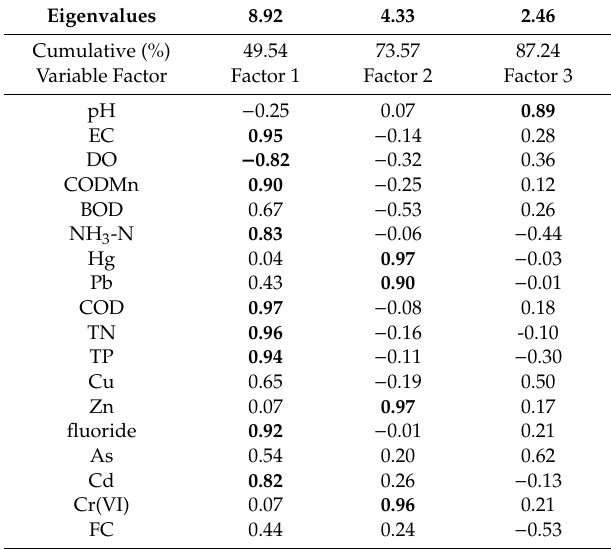
Table 2. Loads of 18 variables in three principal components.